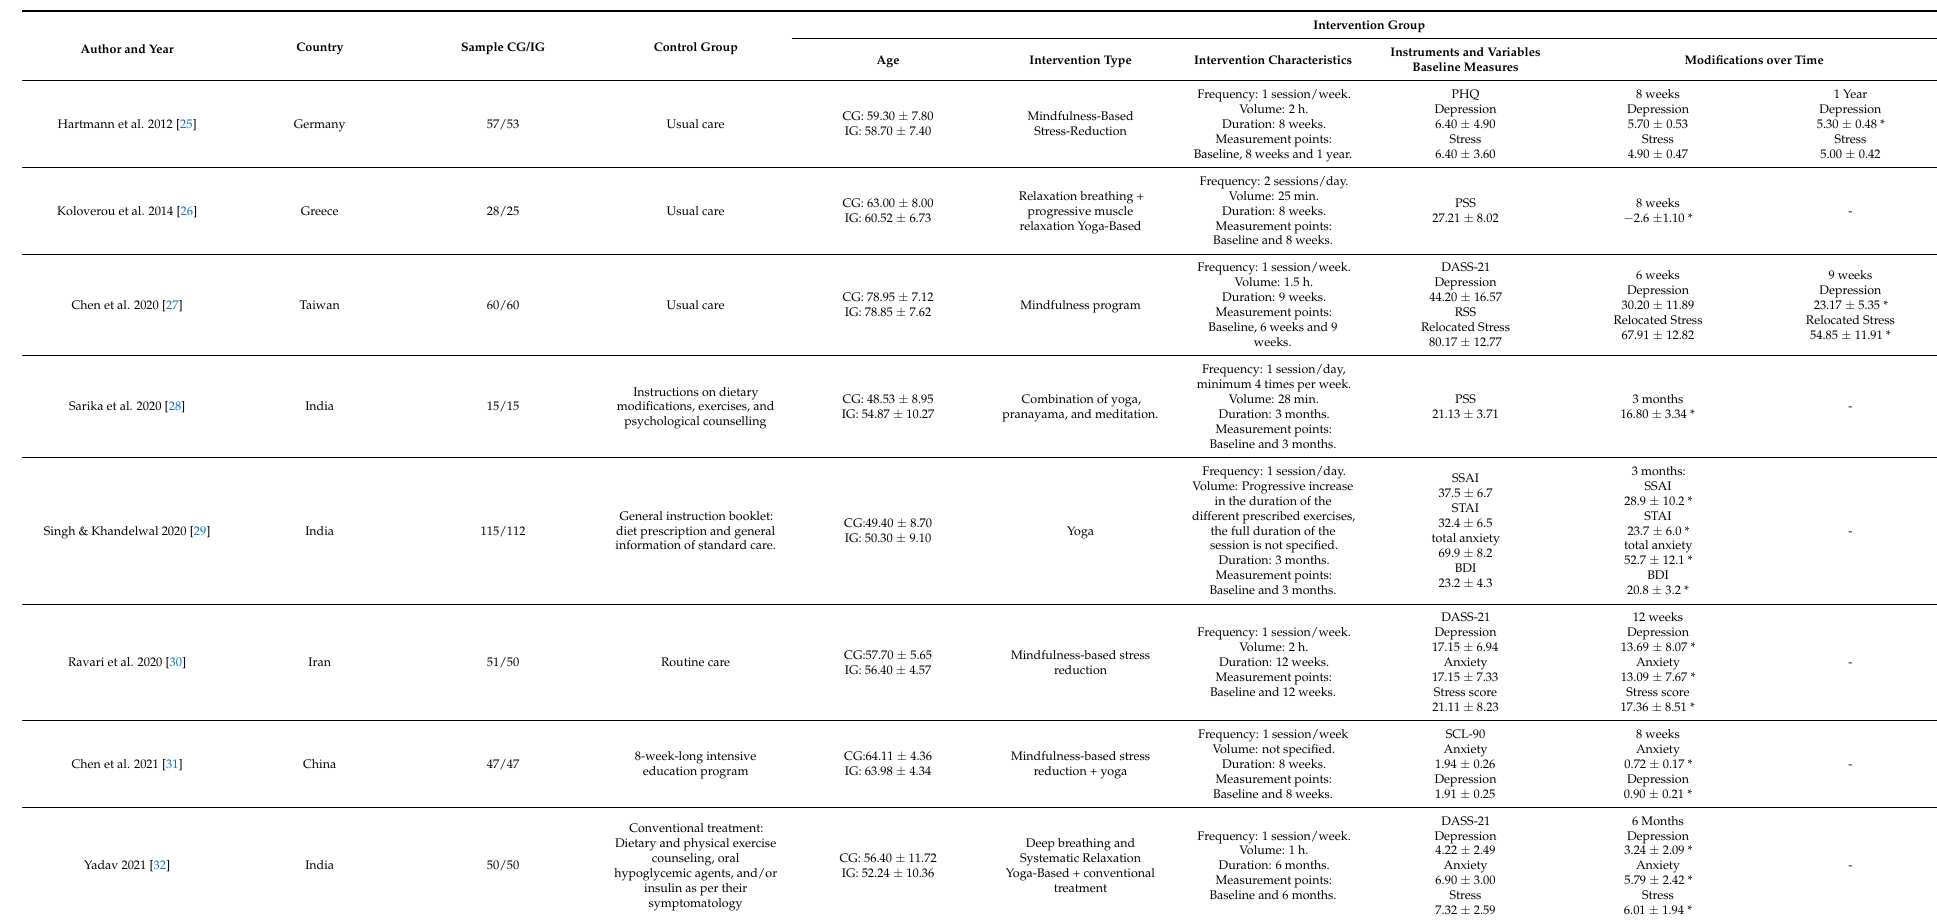
Table 2. Characteristics of the included studies.